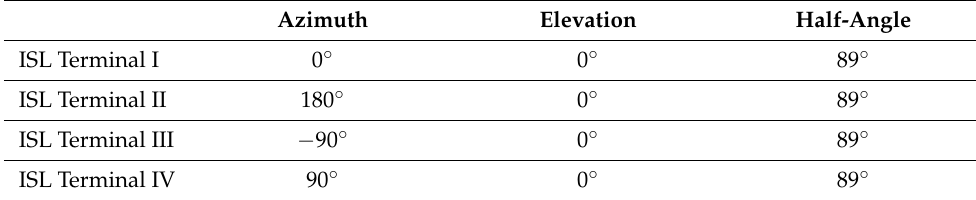
Table 1. Orbital elements of the seed satellite in Walker Delta 32/4/1 constellation. Semi-Major Axis 8500 km Eccentricity 0.0000 Inclination 60 ◦ Longitude of the ascending node 0 ◦ Argument of periapsis 0 ◦ Mean anomaly at epoch 0 ◦